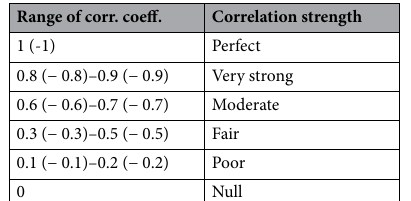
Range of corr. coeff.